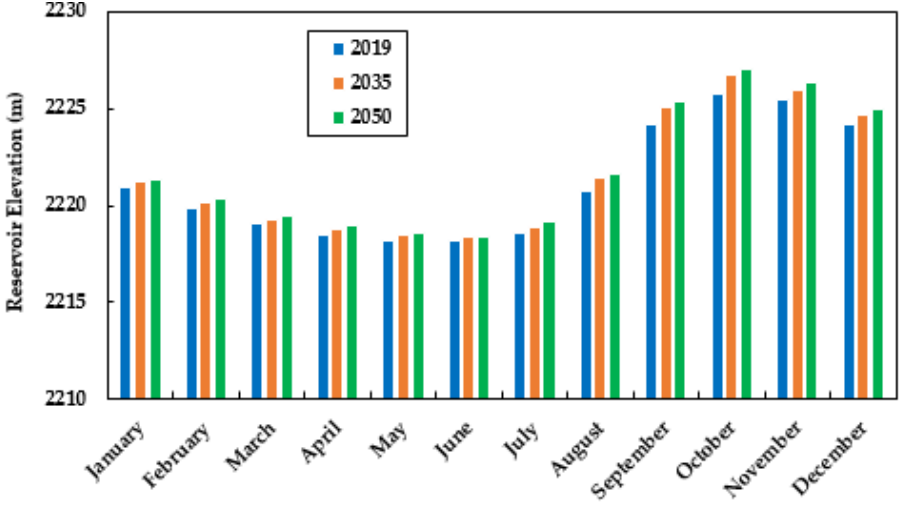
Figure 12. Average monthly current optimized and future reservoir elevation of the Nashe reser- voir.